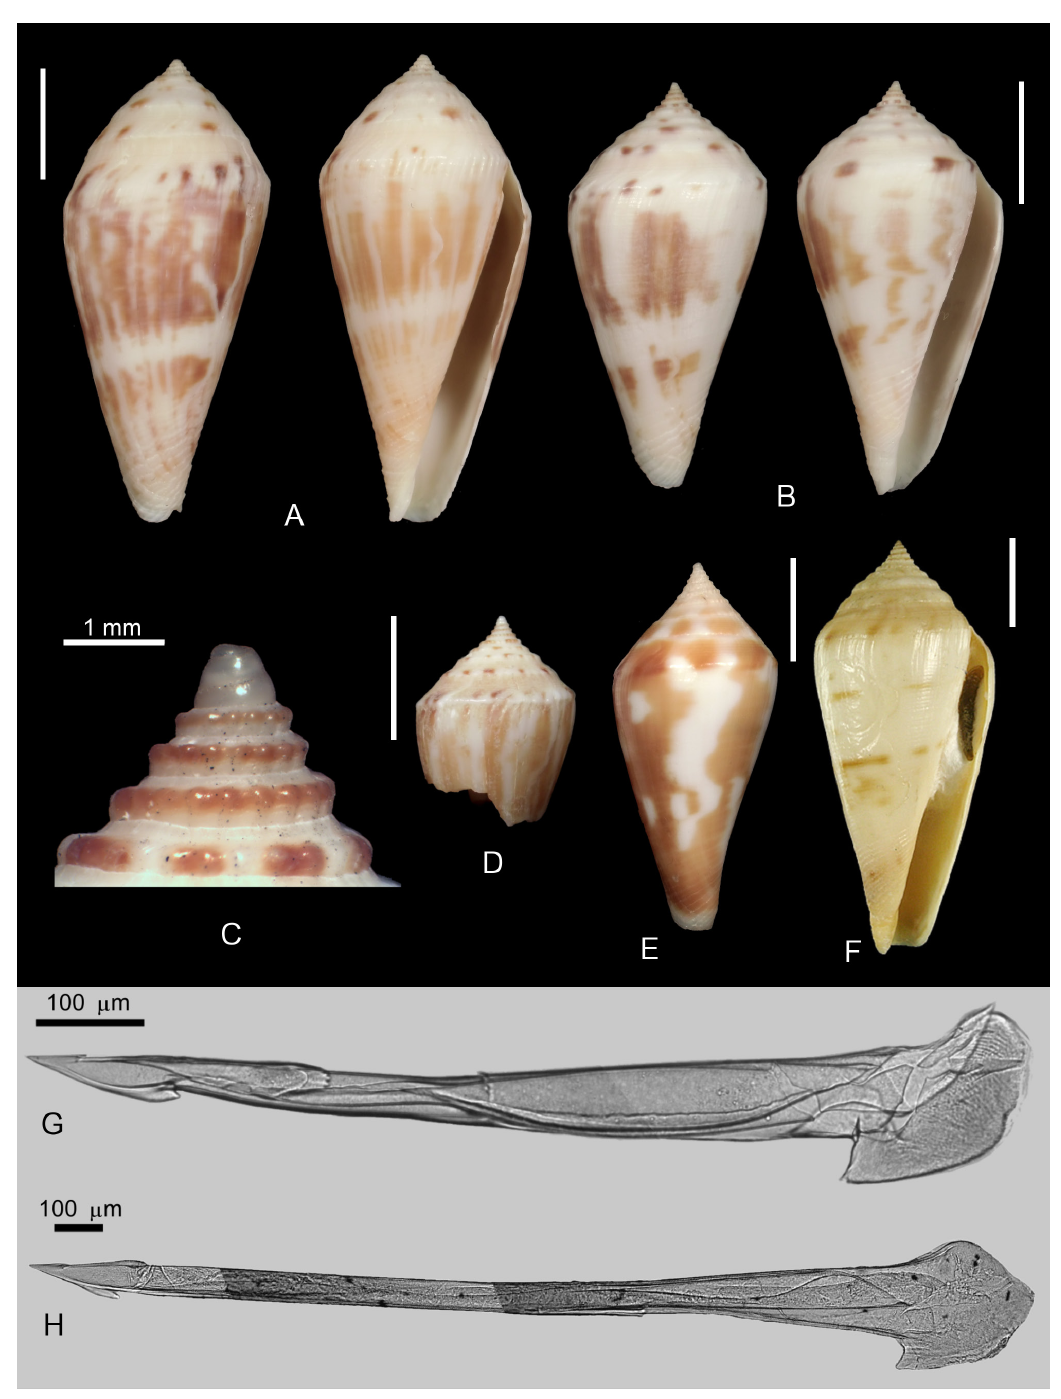
Fig. 9. — A–D . Profundiconus virginiae sp. nov. A . Holotype, 42.5 × 19.4 mm. B . Paratype 1, 33.3 × 16.5 mm. C . Paratype 1, enlargement of the spire. D . Paratype 2 (fragment), 16.3 × 13.0 mm.